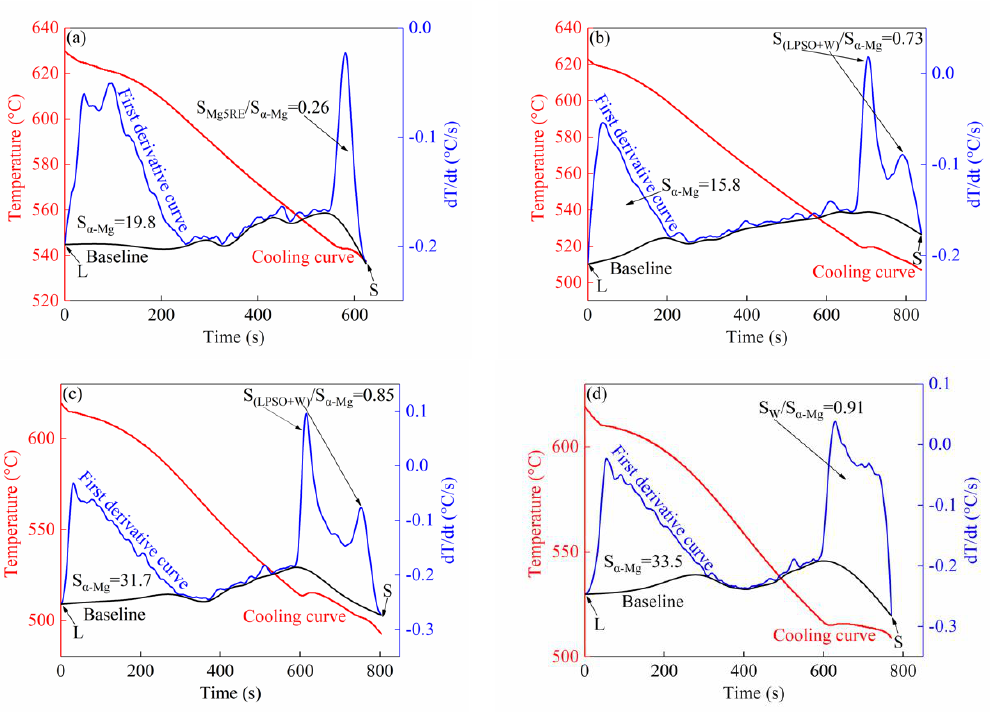
Figure 5. Solidification path of Mg–7Gd–5Y– x Zn–0.5Zr alloys: ( a ) x = 0 wt%; ( b ) x = 3 wt%; ( c ) x = 5 wt%; ( d ) x = 7 wt%. Table 2. The temperatures of phase transformation of Mg–7Gd–5Y– x Zn–0.5Zr alloys solidification path in Figure 5 (temperature, °C).